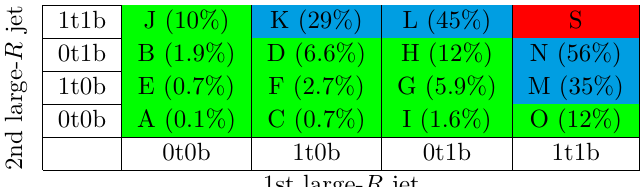
Table 1 . Region labels as a function of tagging states of the leading (’1st large- R jet’) and the second-leading (’2nd large- R jet’) large- R jet. A top-quark-tagged jet is defined by the tagging algorithm described in section 4.1, and denoted by ‘1t’ in the table, while a jet that is not top-quark- tagged is labelled ‘0t’. Jets that are or are not b -tagged are denoted by ‘1b’ or ‘0b’, respectively. The expected proportion of t ¯ t signal events and MC-predicted background events relative to the number of data events in each region is given in parentheses. The regions marked in green, blue, and red correspond to control, validation, and signal regions,